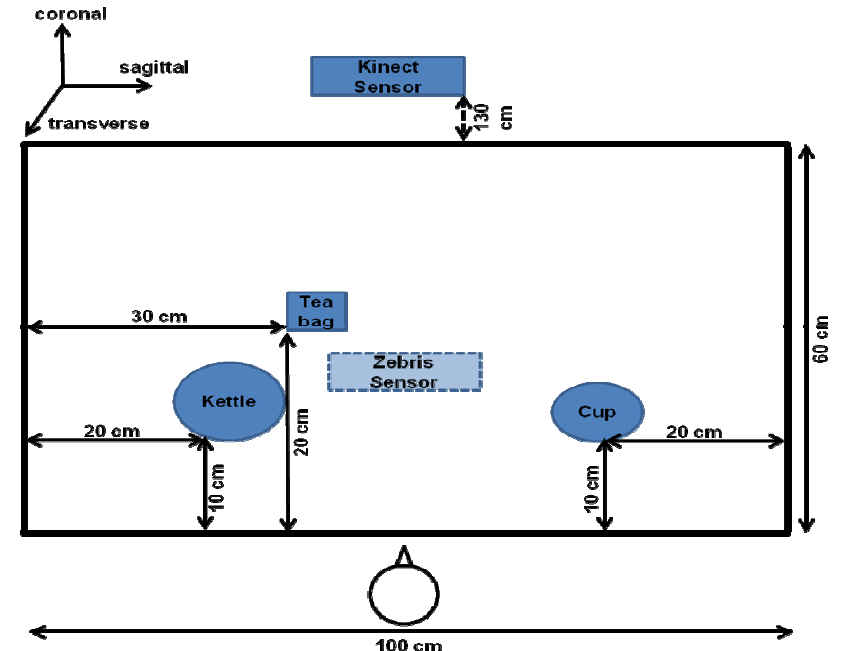
Figure 5. This figure shows the object layout for the experiment. The objects involved: a cup of tea, a kettle, a tea bag; the sensor Kinect TM and the Zebris system. The general Cartesian reference system is also